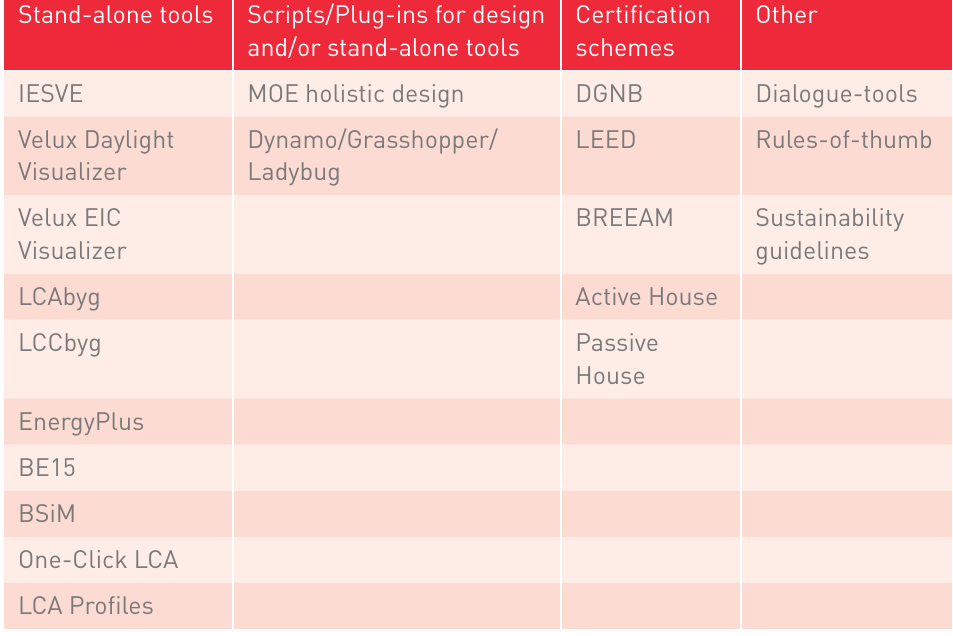
Tools for decision-support mentioned by